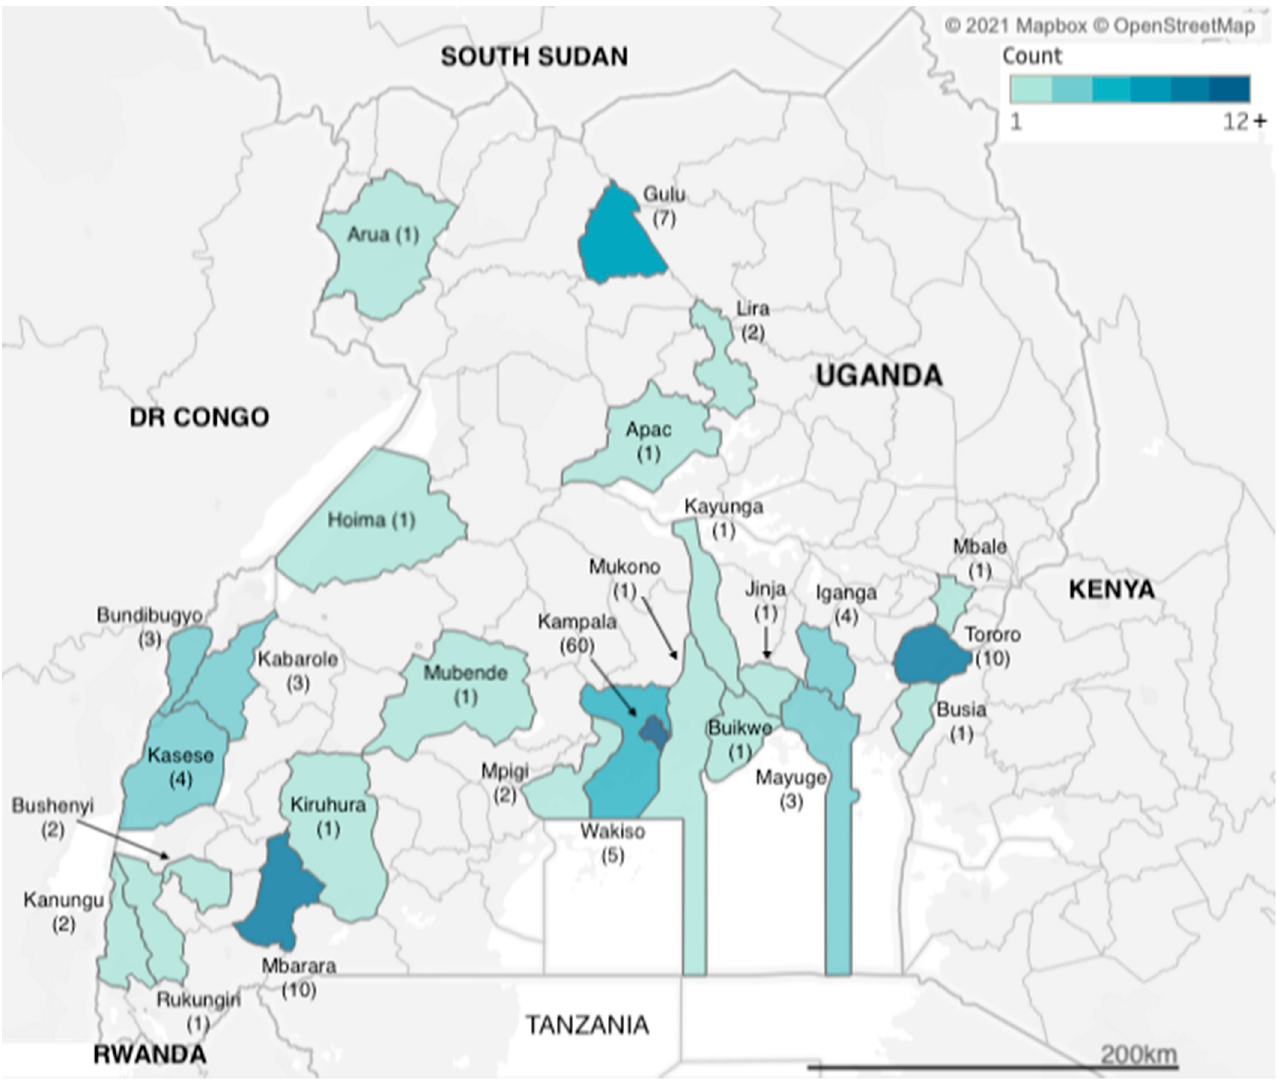
Figure 2. Geographic distribution of included studies.